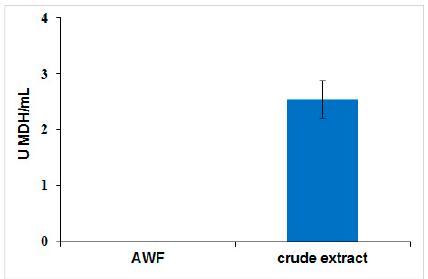
Figure 3. Malate dehydrogenase enzymatic assay. Malate dehydrogenase (MDH) enzyme concentration in whole leaf extract and apoplast wash fluid was monitored by measuring depletion of NADH at 340 nm over 5 min at 25 ◦ C and pH 7.4. The whole leaf extract was diluted for the data normalization the apoplast wash fluid. Error bars were determined from propagation of standard errors calculated from triplicate technical assays performed.